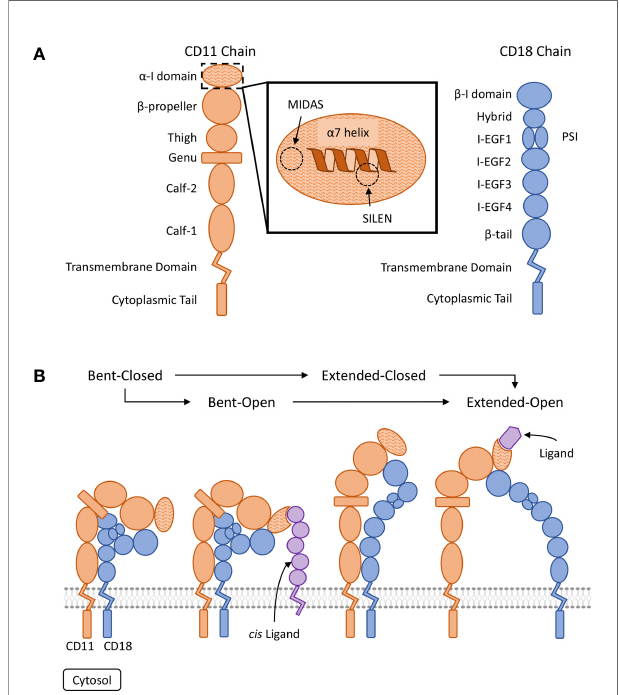
FIGURE 1 | Visual representation of b 2 integrin structure and conserved regulatory conformations. (A) Organization of the domains composing the CD11 and CD18 chains (15, 16). The ligand binding a -I domain is highlighted by a hatched pattern. The metal ion-dependant adhesion site (MIDAS) and the socket for isoleucine (SILEN) motifs are located within the a -I domain (16, 17). The SILEN motif interacts with an invariant isoleucine located in the a 7 helix to maintain the inactive conformation (17). (B) Representation of the b 2 integrin regulatory conformations. The bent-closed inactive conformation predominates under basal conditions (1). Stimulation can activate the integrin and induce the extended-closed conformation. Additional stimulation and the binding of a divalent metal ion to the MIDAS motif, can induce the extended- open conformation. The bent-open conformation is stabilized by binding a cis ligand and may provide an alternative activation pathway to the extended- open conformation (18 – 20). The extended-open conformation is characterized by the separation of the cytosolic tails in additional to local conformational changes within the a -I domain, including shifting of the a 7 helix (14 – 16, 21,